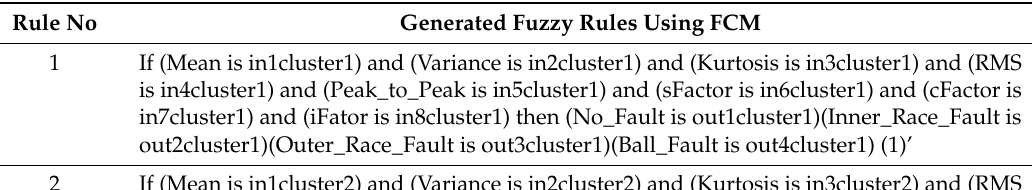
Table 6. Fuzzy rule base for bearing fault classification.